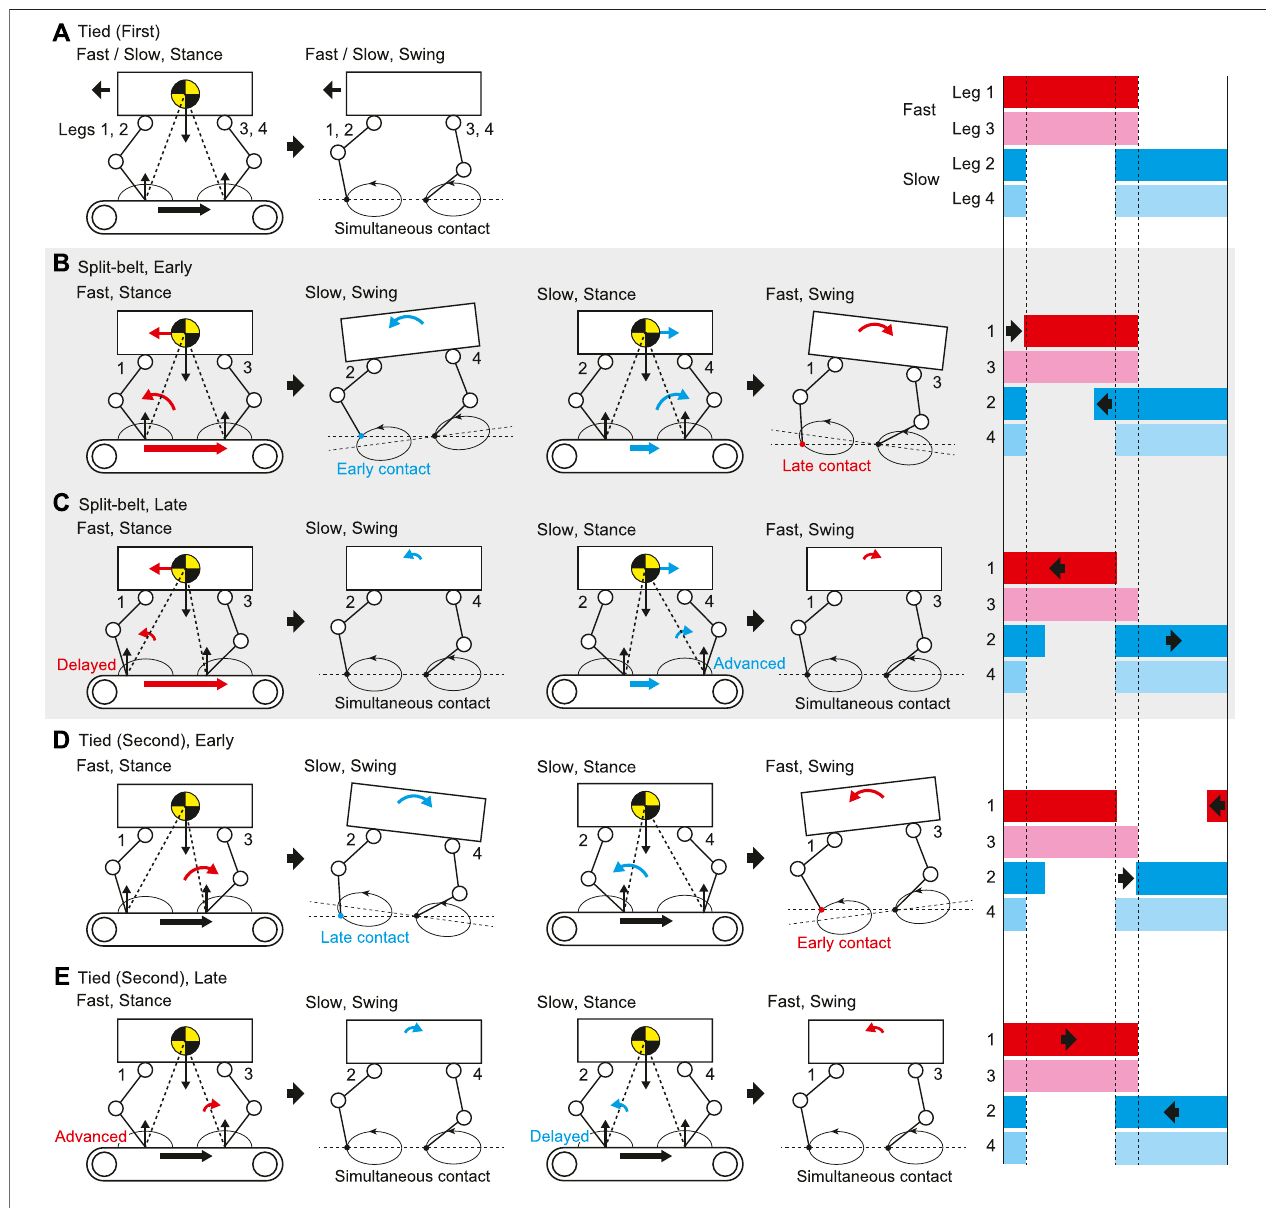
FIGURE 9 | Gait adaptation mechanism through re fl ex and learning based on foot contact timing in (A) fi rst tied, (B) early stage of split-belt, (C) late stage of split-belt, (D) early stage of second tied, and (E) late stage of second tied con fi gurations. Right fi gures show foot diagrams.